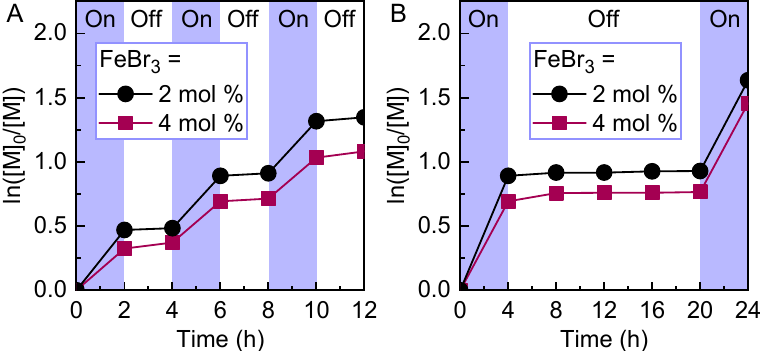
Figure 1. Temporal control in photoinduced iron-catalyzed ATRP of trifluoroethyl methacrylate (TFEMA). Better temporal control was achieved by decreasing the concentration of the iron catalyst from 4 to 2 mol%. Reaction conditions: [TFEMA] / [EBPA] / [FeBr 3 ] / [TBABr] = 50 / 1 / x / 2x (x = 0.02 or 0.04) in 50 vol% solvent (trifluoroethanol / anisole = 9 / 1), irradiated under blue LEDs (465 nm, 12 mW / cm 2 ). Reproduced with permission from Ref [41].